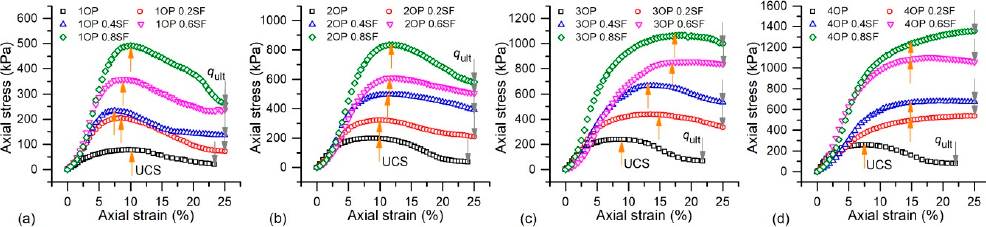
Figure 7. The axial stress-strain curves of OPSS and OPSFRS: ( a ) C op = 1%, ( b ) C op = 2%, ( c ) C op = 3%, and ( d ) C op = 4%.